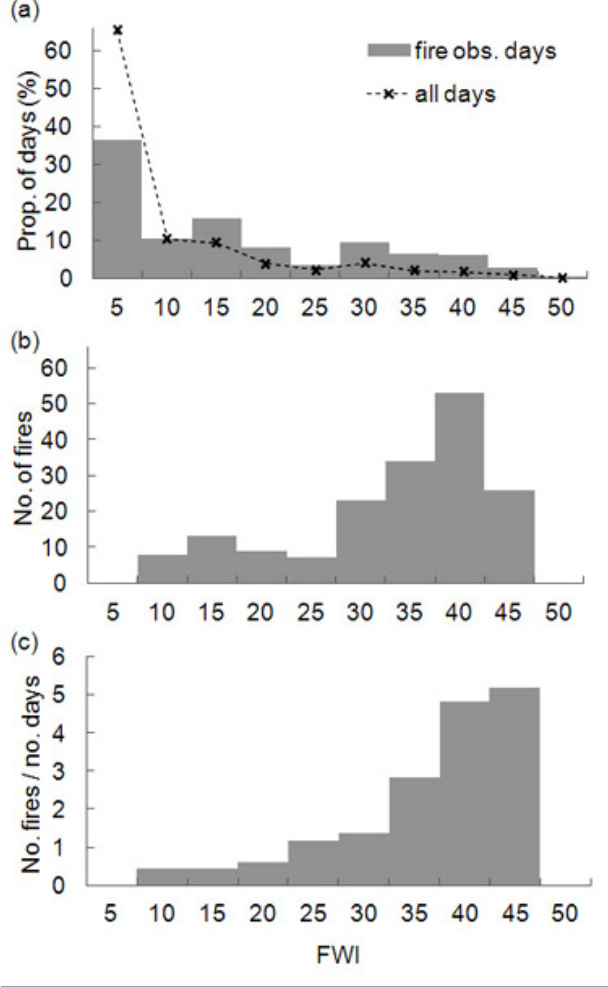
Fig. 6 . (a) The proportion of days per Fire Weather Index (FWI) class. x denotes the relative proportion of all measured days, including the rainy season. The grey bars show the proportion of observation days for the dry season days only. (b) The number of observed fires per FWI class. (c) Fire occurrence per FWI class expressed as number of observed fires/number of observation days in each FWI class. The number on the FWI axis is the upper limit of each FWI class.